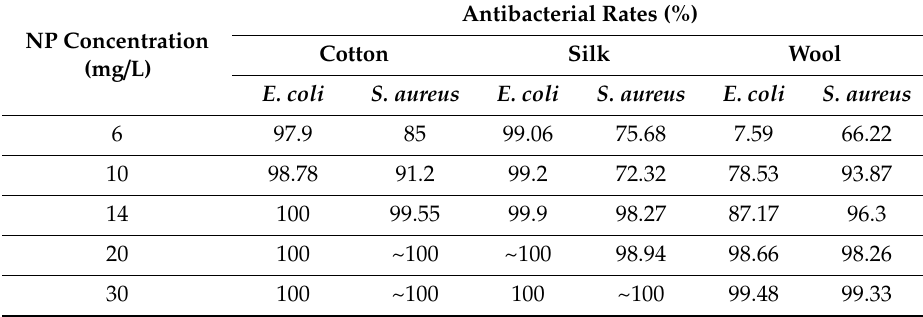
Table 2. Antibacterial rates of as-prepared Ag, Au, and Pt NP-coated cotton, silk, and wool